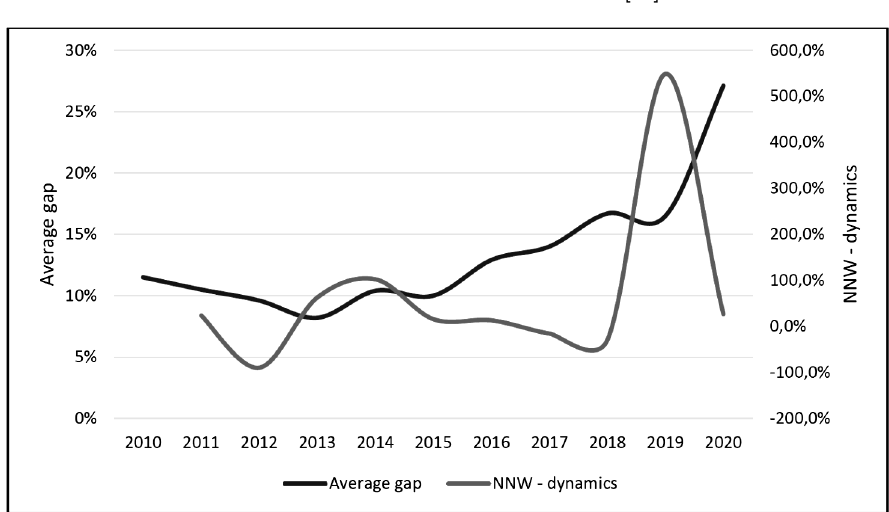
Average loans mismatch on the public balance sheet and the change in national net welfare in Poland